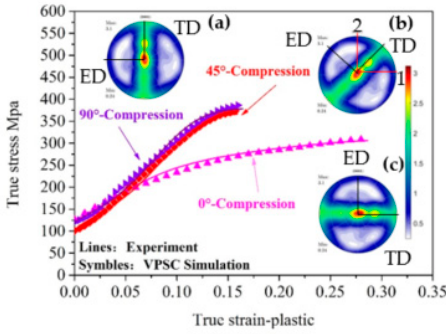
Figure 3. Experimental (symbol) and simulated (line) stress-strain curves under uniaxial compression and corresponding initial texture of ( a ) E0; ( b ) E45; ( c ) E90.